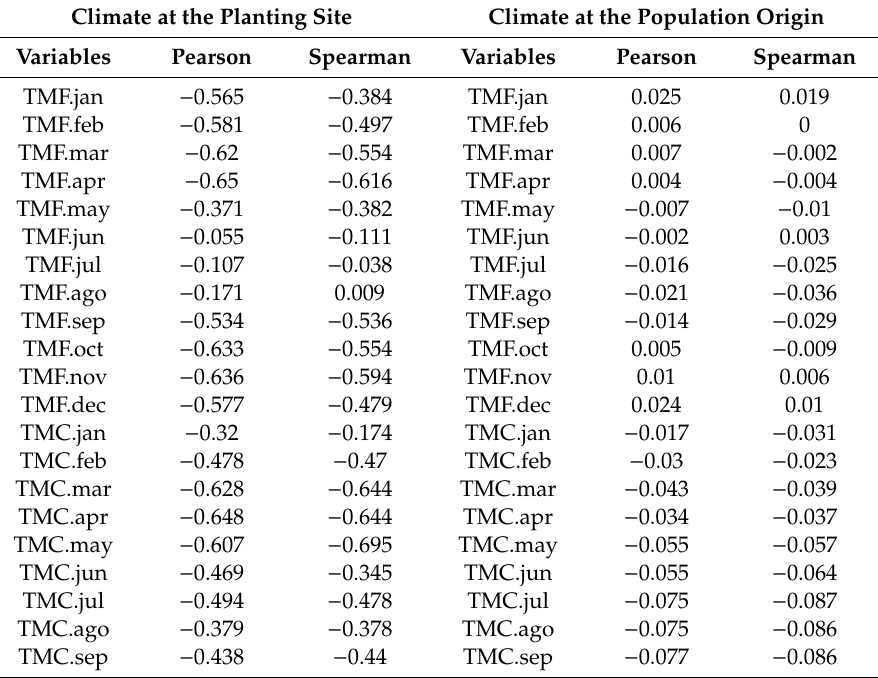
Table A1. Pearson and Spearman correlation coe ffi cients between climate data, at the planting sites and at the population origin, and tree height growth of Scots pine from